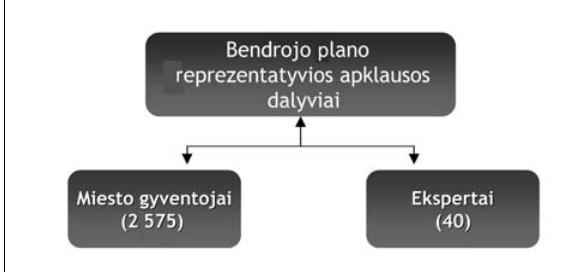
Fig 5. Respondents of representative poll of the general plan